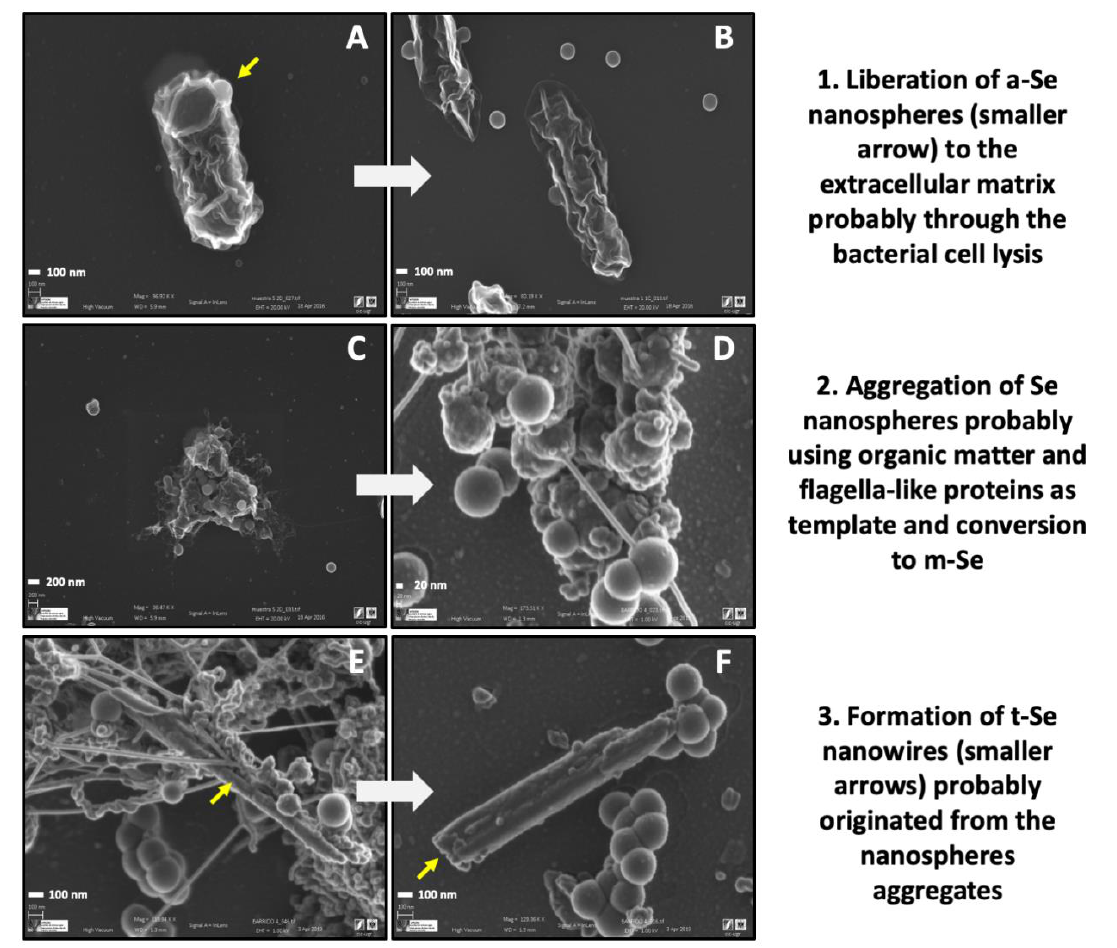
Figure 8. VP-FESEM images representing the proposed transformation from a-Se nanospheres to t-Se nanowires through the formation of m-Se aggregates as an intermediate step by using proteins as a template. The images correspond to samples prepared by growing S. bentonitica anaerobically at an initial pH of 10. Scale bars: 100 nm ( A , B , E , F ), 200 nm ( C ), and 20 nm ( D ).